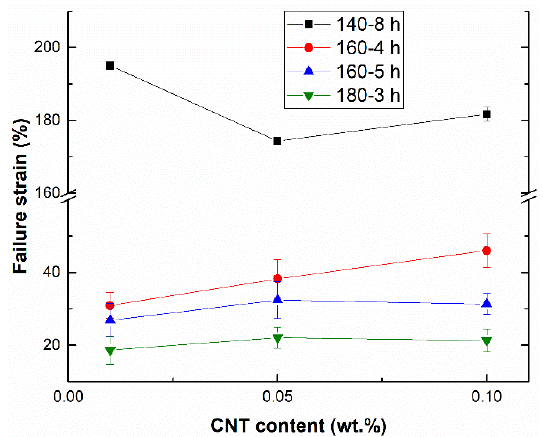
Figure 4. Failure strain measurements of the different tested conditions.